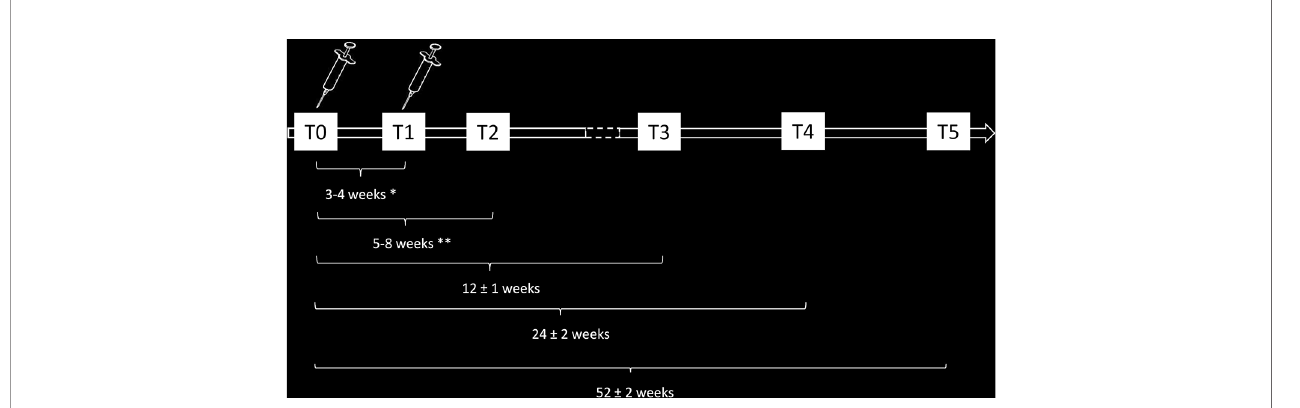
FIGURE 2 | Schematic representation of the timeline of immunomonitoring of the clinical